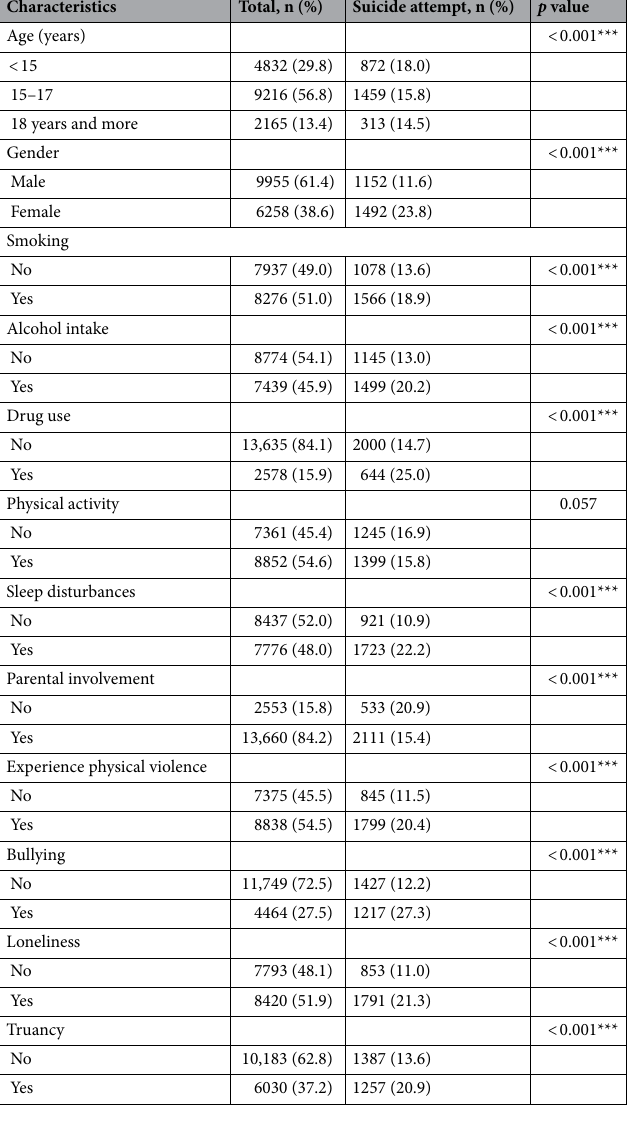
Table 2. Description of sample (n = 16,213). **** p < ; *** p < 0.001; ** p < 0.01; * p <